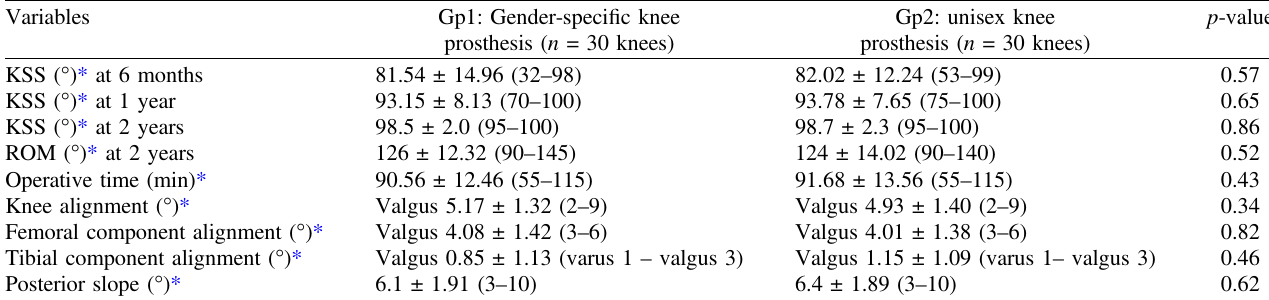
Table 4. Secondary